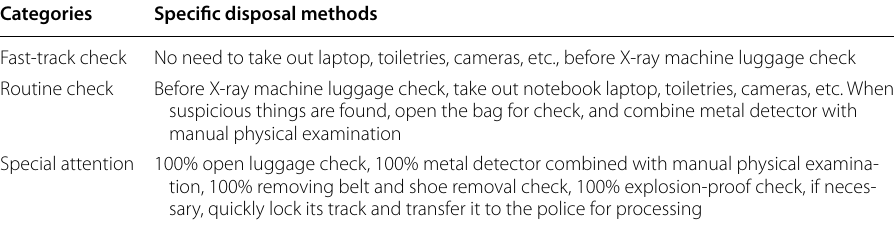
Table 2 Graded security check and disposal Categories Specific disposal methods Fast-track